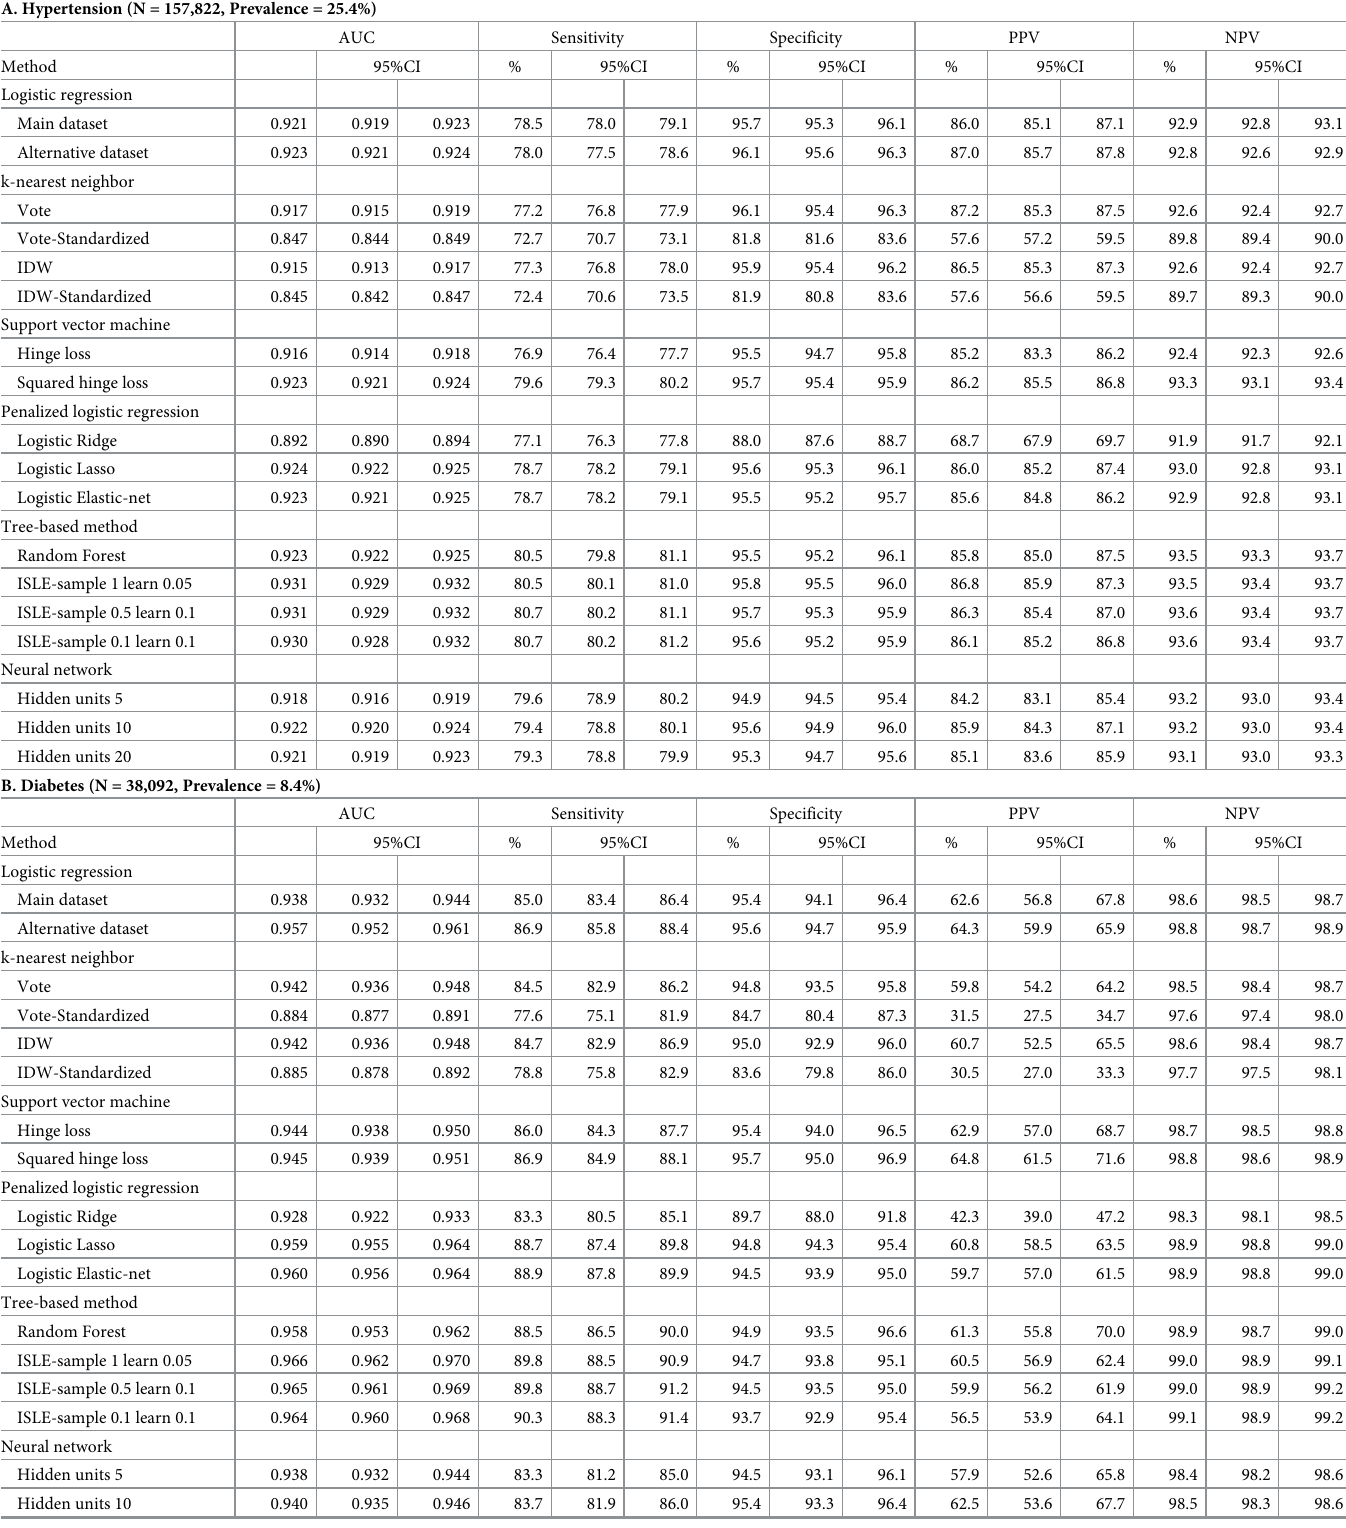
Table 5. Association measures and their 95% confidence intervals for claims-based algorithms derived from machine learning methods. A. Hypertension (N = 157,822, Prevalence =